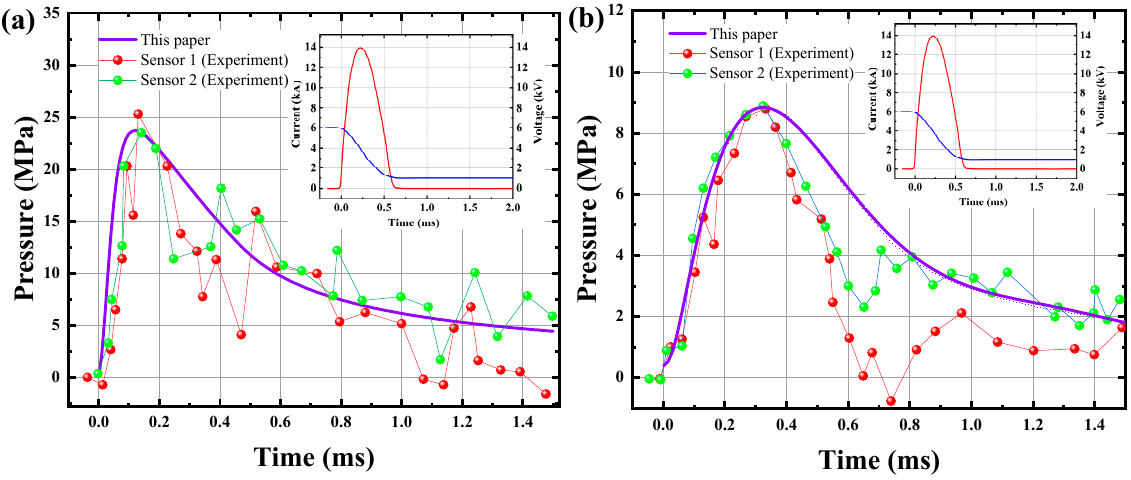
Figure 14. Validation of this paper’s results against the experiment results from Park et al. (2011) [49] for shock wave pressure. ( a ) Chamber diameter: 110 mm ( b ) Chamber diameter: 250 mm.